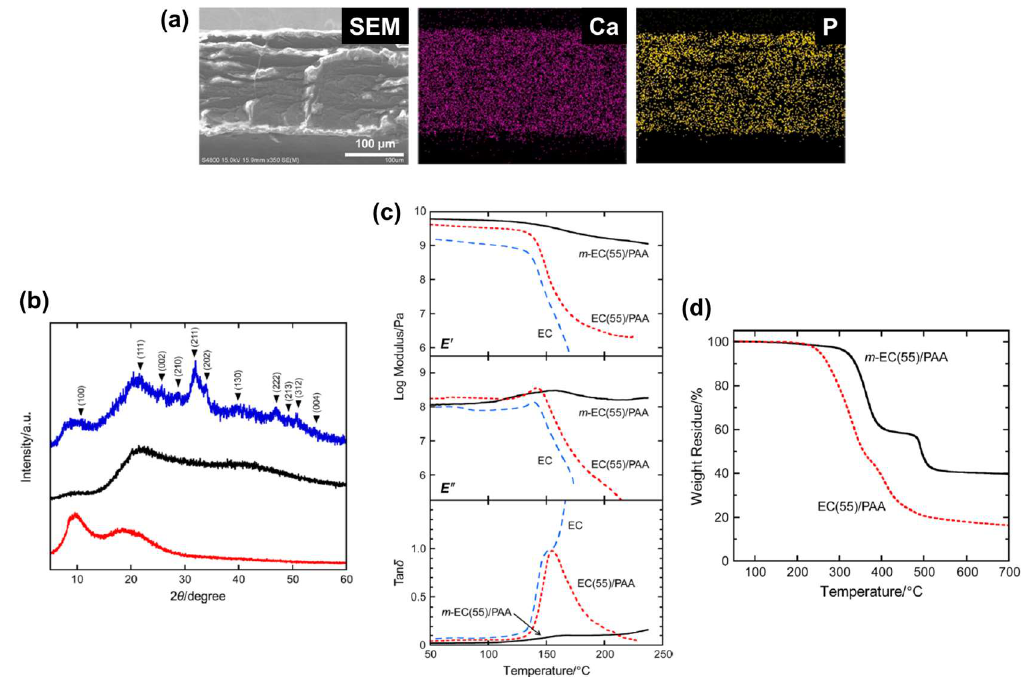
Figure 3. ( a ) Scanning electron microscope (SEM) image and energy-dispersive X-ray mappings of Ca and P for the fracture surface of an m -EC(55)/PAA film. ( b ) Wide-angle X-ray diffraction intensity profiles of EC(55)/PAA (bottom), m -EC(55)/PAA (center), and p- m -EC(55)/PAA film (top). ( c ) Temperature dependence of the storage modulus E ’, loss modulus E ’’, and loss factor tan δ for EC (dashed line), EC(55)/PAA (dotted line), and m -EC(55)/PAA film (solid line). ( d ) Thermogravimetric analysis profiles for EC(55)/PAA and m -EC(55)/PAA films (( a – d ) were reprinted with permission from [63], Copyright (2021) American Chemical Society).